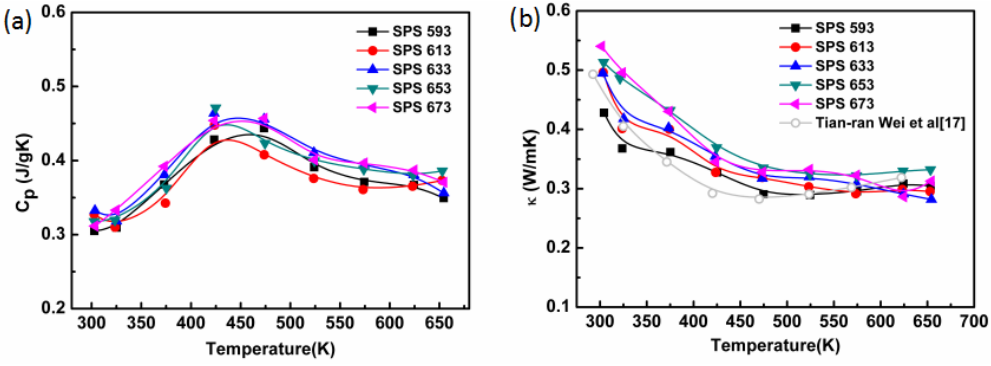
Figure 5. ( a ) C P and ( b ) κ of samples as functions of temperature with reported values by Wei et al. [17].